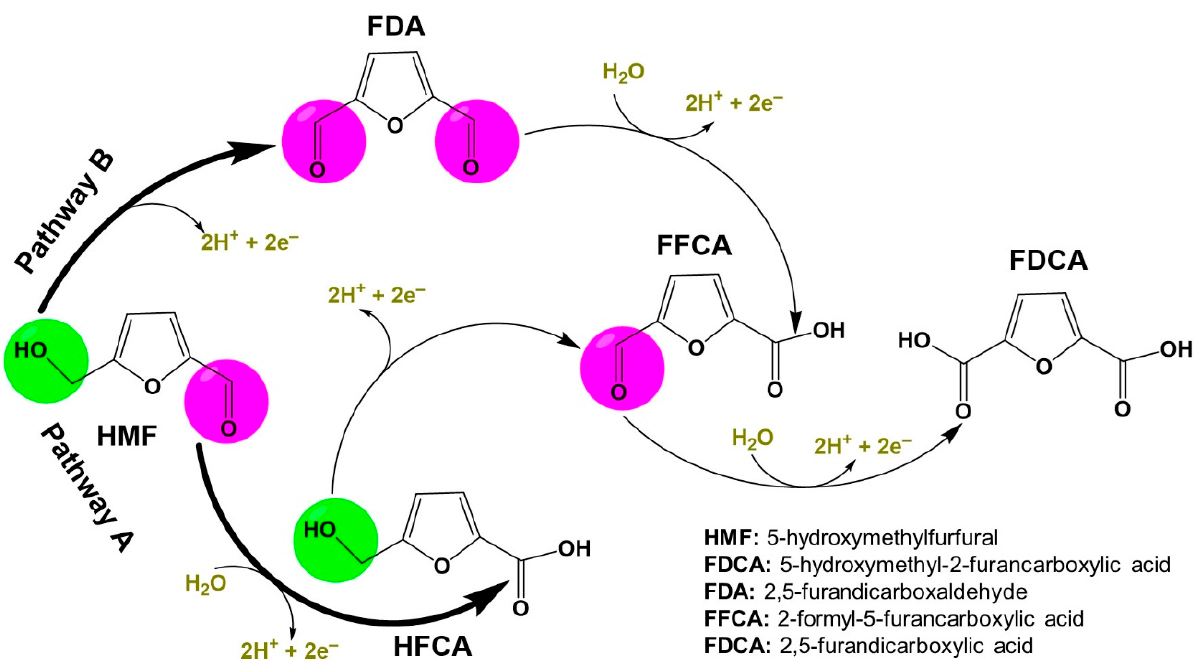
Figure 11. Scenarios of the electrocatalytic oxidation of HMF and the resulting products without C-C bond cleavage (written in acidic media).